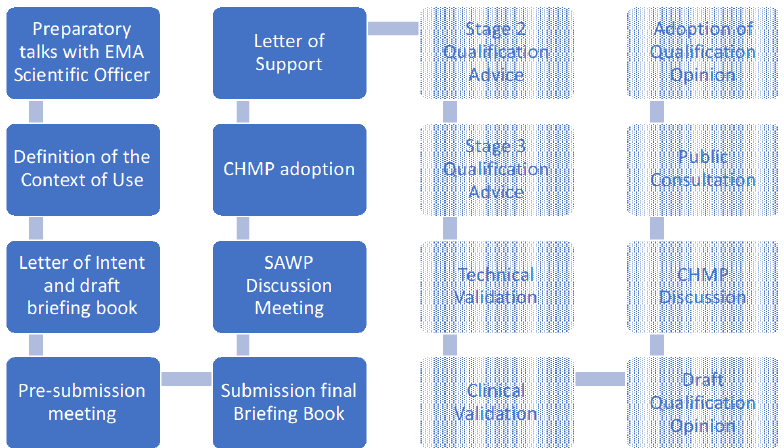
Figure 1. The complete workflow European Medicine Agency (EMA) qualification of novel methodologies for medicine development. The blue boxes are covered in this paper.